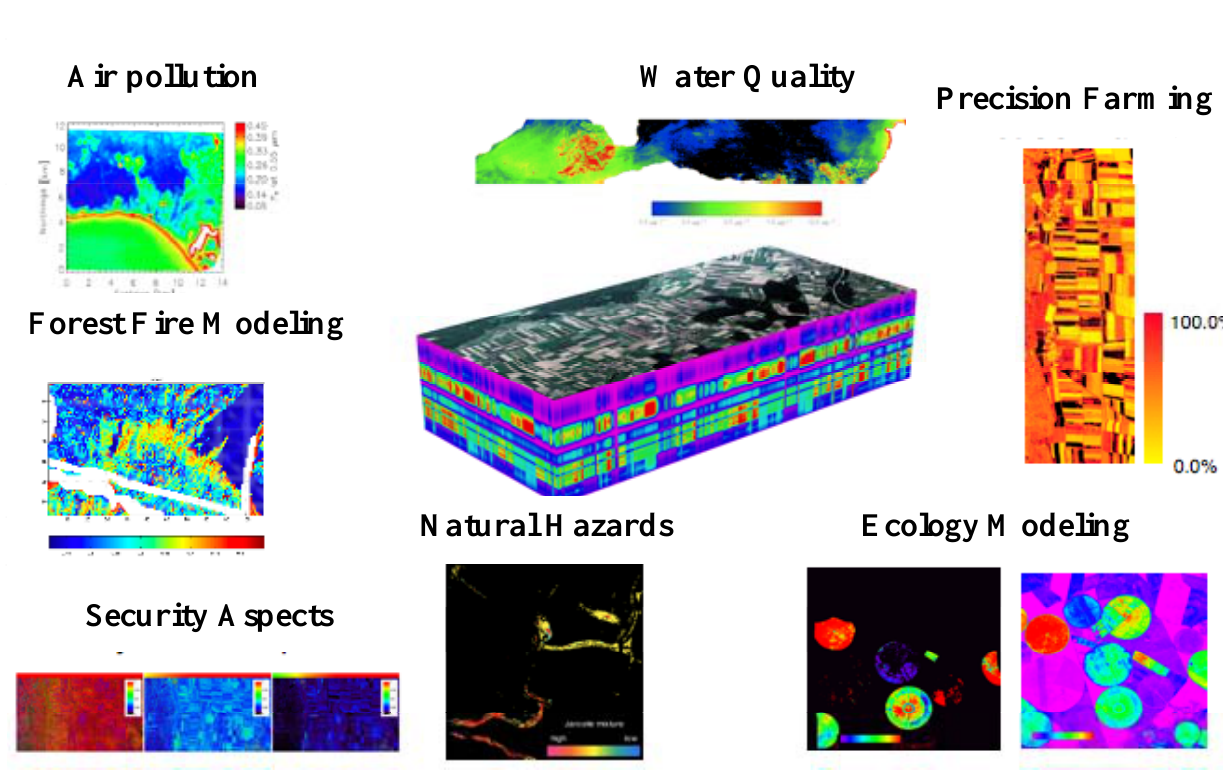
Figure 8. Example of APEX